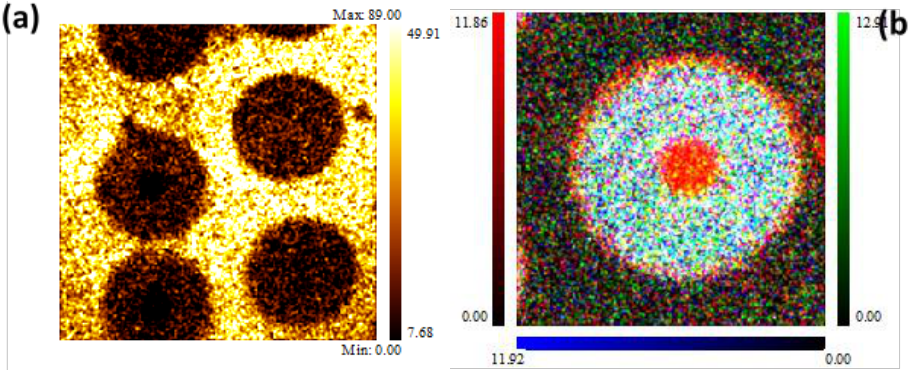
Figure 17. XPS images: ( a ) Ti 2p—400 × 400 µm 2 ; ( b ) Si 2p (blue), C 1s—190 × 190 µm 2 , carbide (green) and graphite (red) [29].